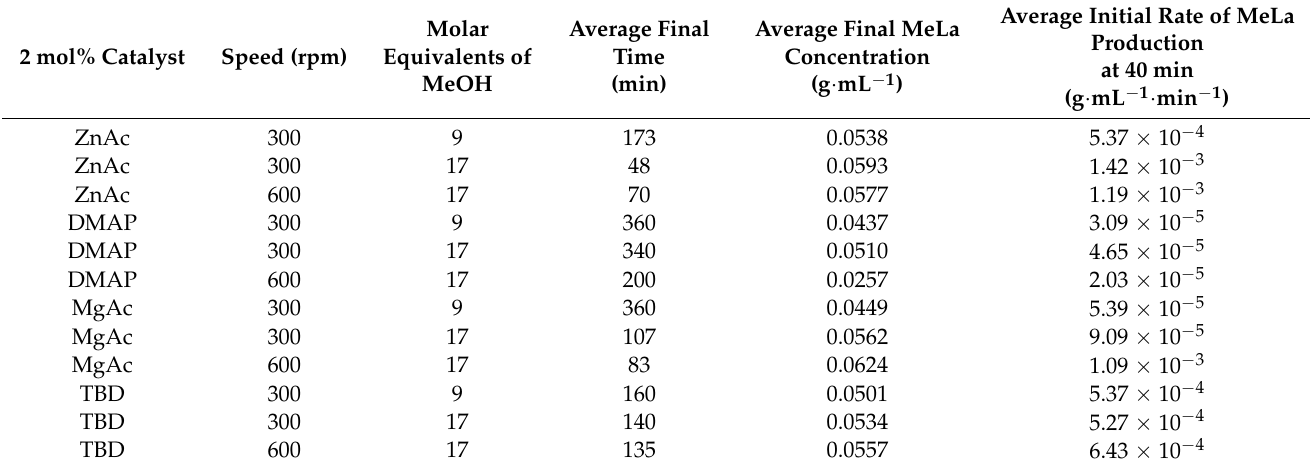
Table 1. Methanolysis of 2 g PLA at 130 ◦ C and 2 mol% of catalyst, 9–17 equivalents MeOH. Repeats (3–4 repeats) were